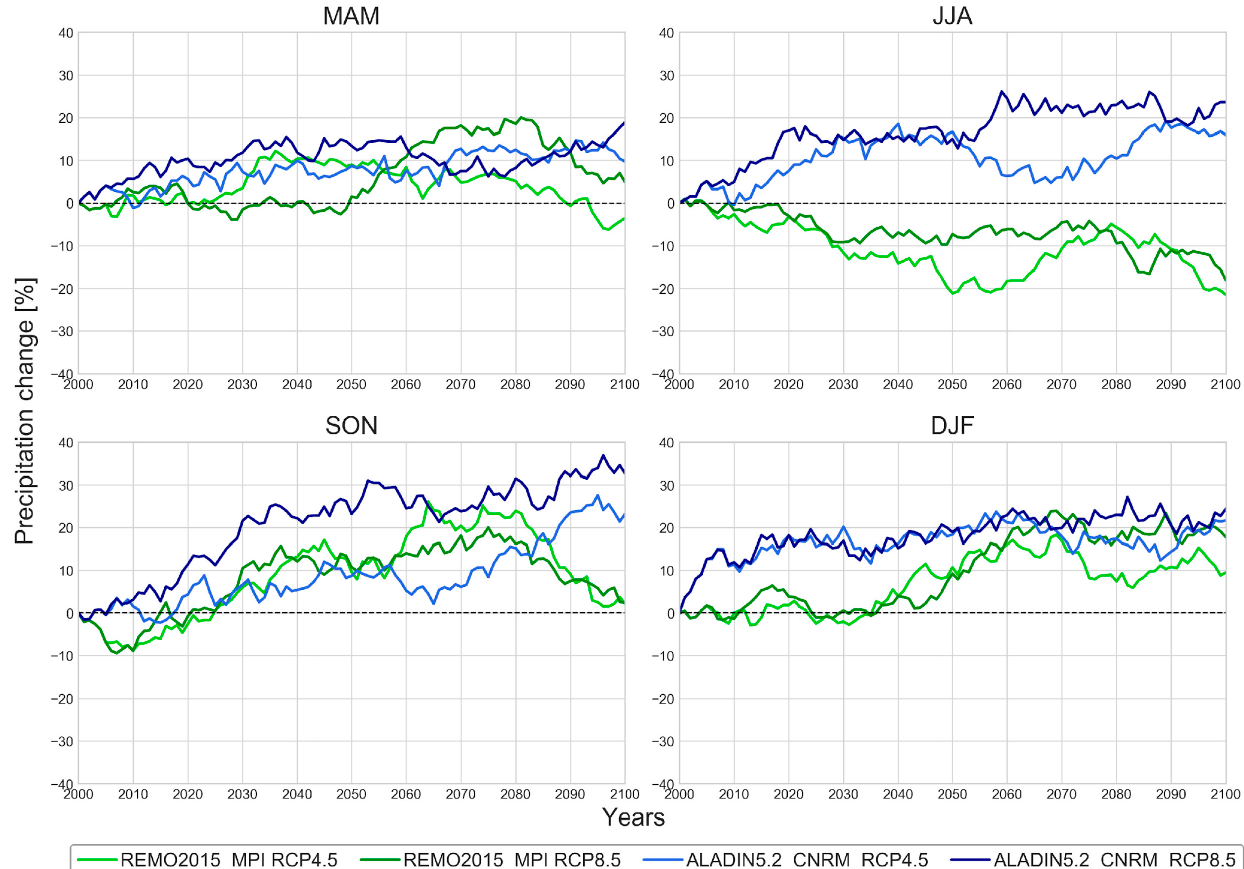
Figure 18. Temporal evolution of the changes in seasonal precipitation over Hungary in 2000–2100 based on the ALADIN5.2 and REMO2015 simulations, smoothed with the moving average of a 30-year window. Reference period: 1971–2000.